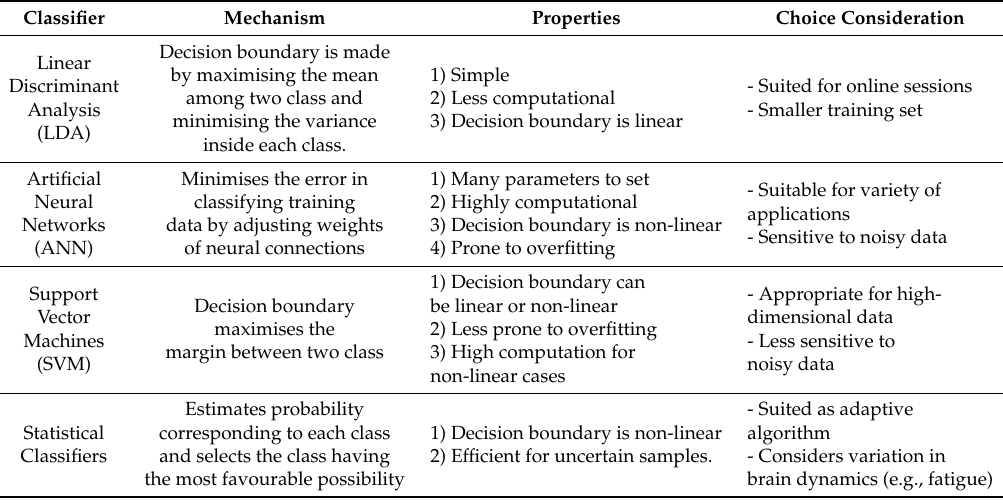
Table 2. Comparison of classification algorithms.